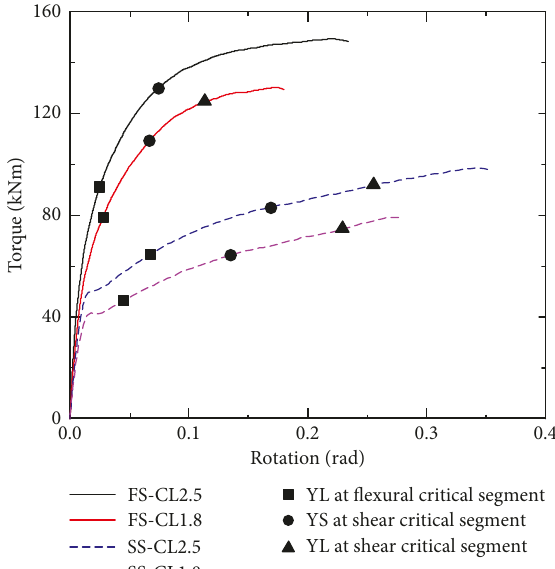
Figure 20: Simulated results of girders with various characteristic lengths. “FS” and “SS” mean “fixed-fixed supported” and “simply supported,” respectively; “YL” and “YS” mean “yielding of longitudinal bars” and “yielding of stirrups,” respectively.